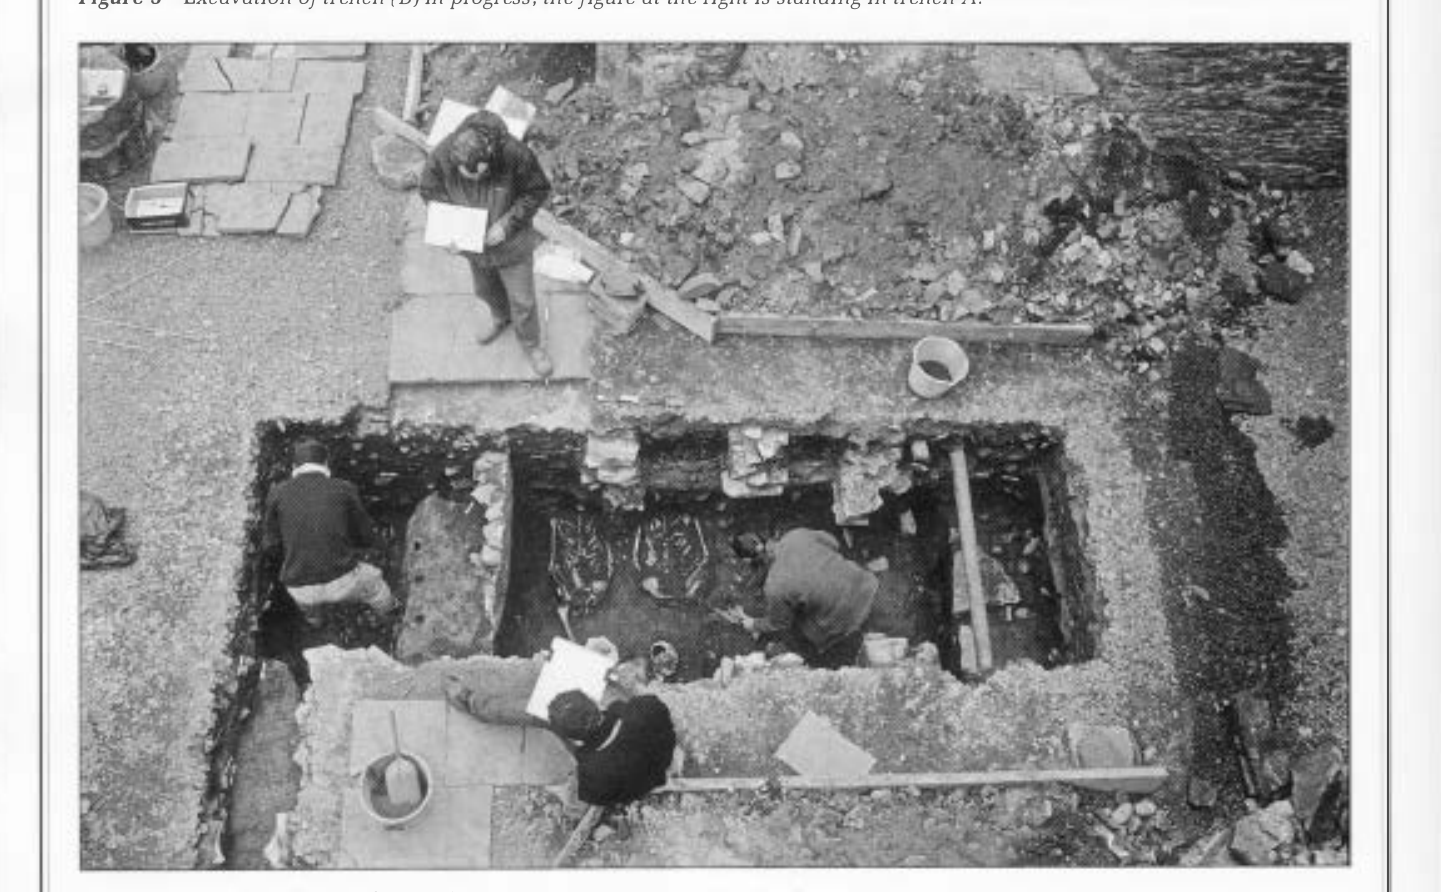
Figure 6 Trench B, showing burials found in the medieval graveyard